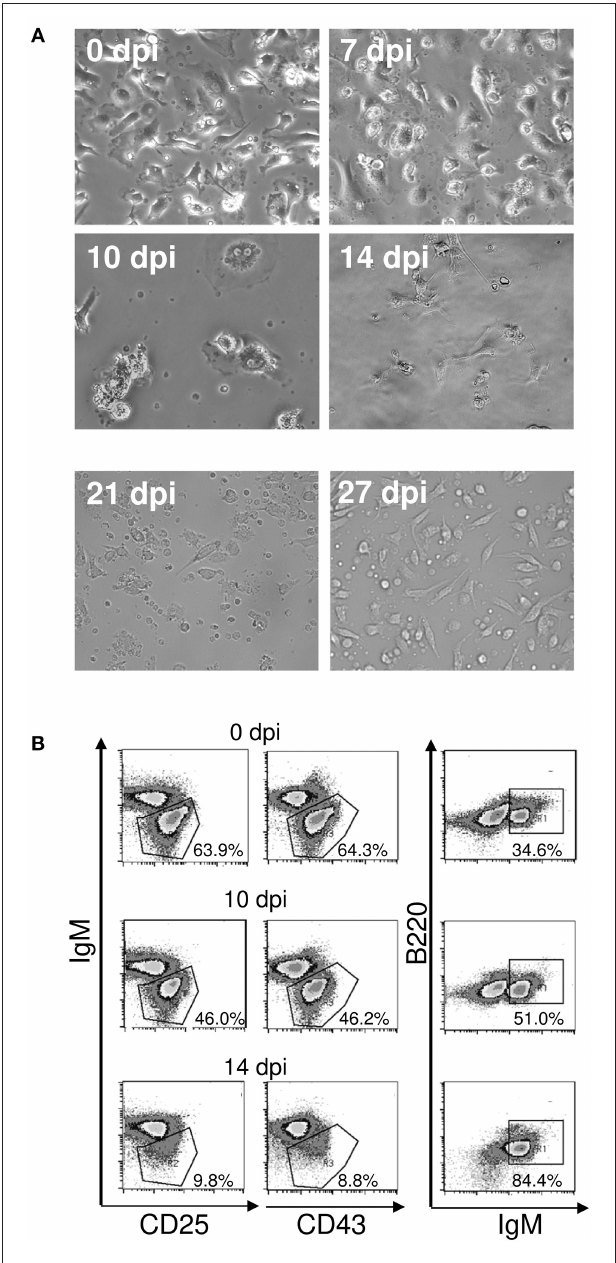
FIGURE 7 | (A) Loss of function of bone marrow stromal cells during acute T. cruzi infection. C57BL/6 mice were infected with 75 T. cruzi blood trypomastigotes i.p. Bone marrow isolated from femurs of uninfected and infected mice were cultivated after removal of non-adherent cells. Representative photomicrographs of stromal cell cultures of 15 mice are shown. (0–10 d.p.i., magnification 400x; 14–27 d.p.i., magnification 300x). (B) Maintenance of pro- and pre-B cells. B220 + IgM − B cell progenitors were isolated by FACS and incubated with adherent bone marrow stromal cells from uninfected and infected mice. After 3 days, the frequencies of B220 + CD25 + pre-, B220 + CD43 + pro-, and B220 + IgM + immature B cells were analyzed by flow cytometry. Shown are representative plots from two independent experiments with 5 mice per experiment.